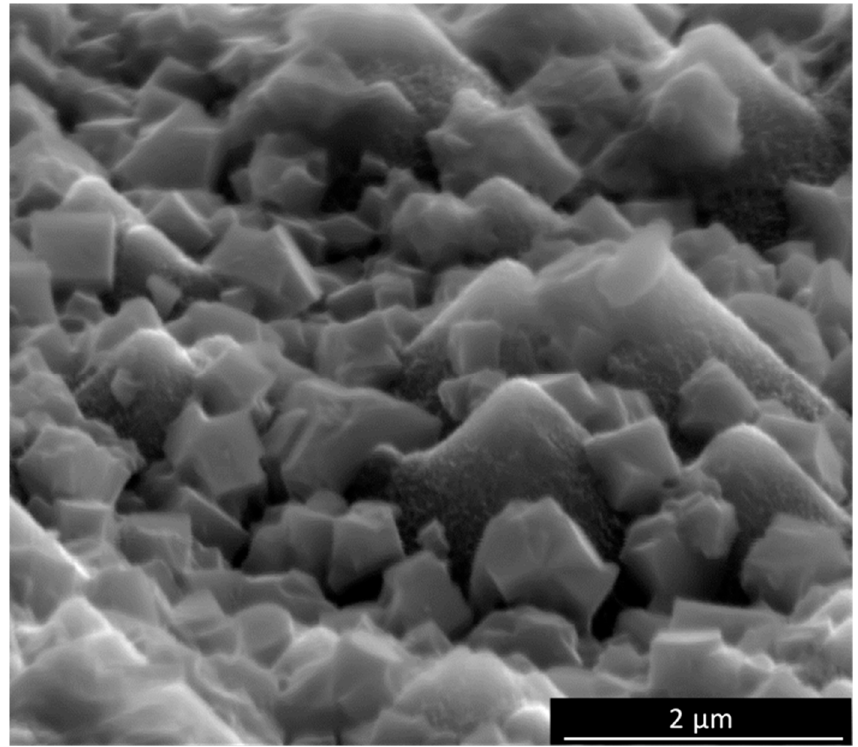
Figure 5. SEM image of the silicon wafer with 300–400 nm wires etched by thee MAE technique with a perovskite layer obtained in a two-step deposition process (13.00 kV, mag. 50,000×).